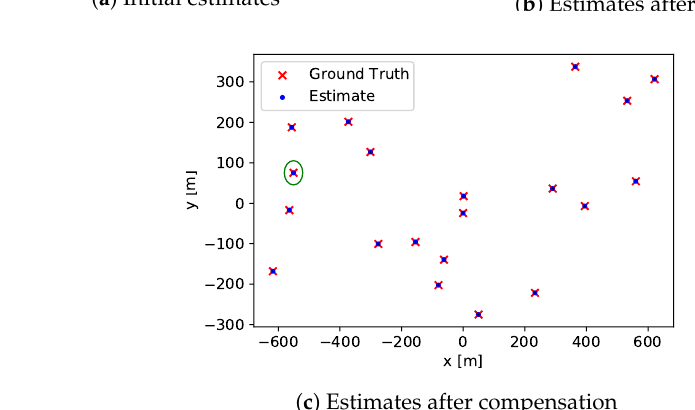
Figure 3. Changes of estimates during the execution of the proposed